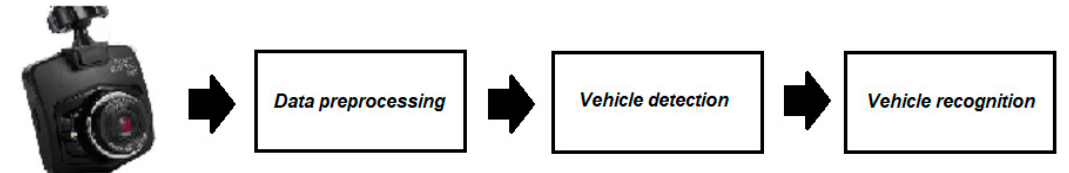
Figure 1. Proposed model of the system.